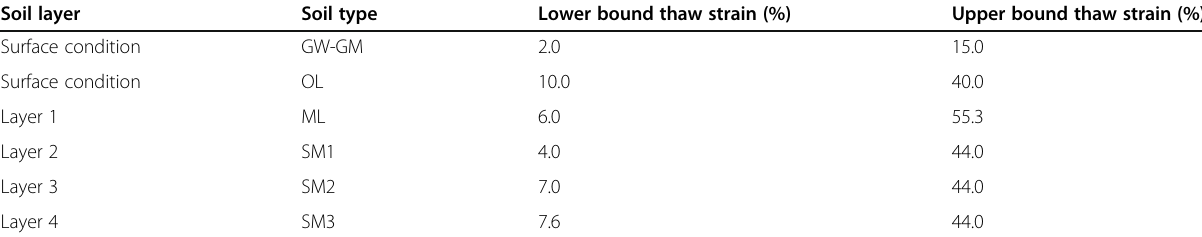
Table 4 Lower and upper bound strain values in this study Soil layer Soil